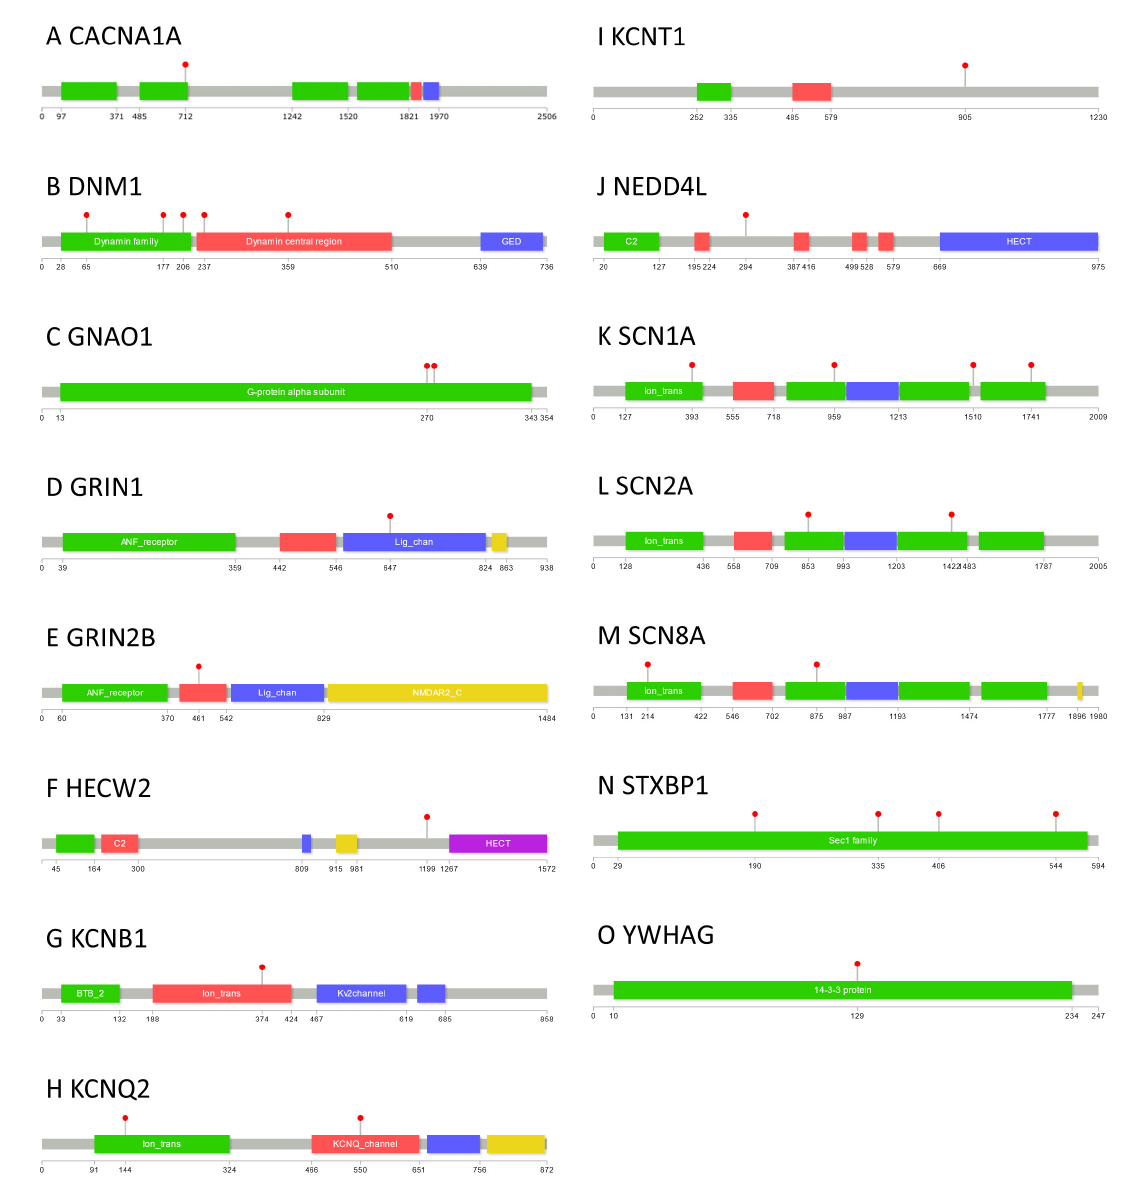
Figure 1. Case-ascertained de novo mutation locations within the epilepsy genes. Red lollipops denote the locations of identified variants from the epilepsy cohort in 15 of the 34 target genes. Pfam constitutes the source for the domains.